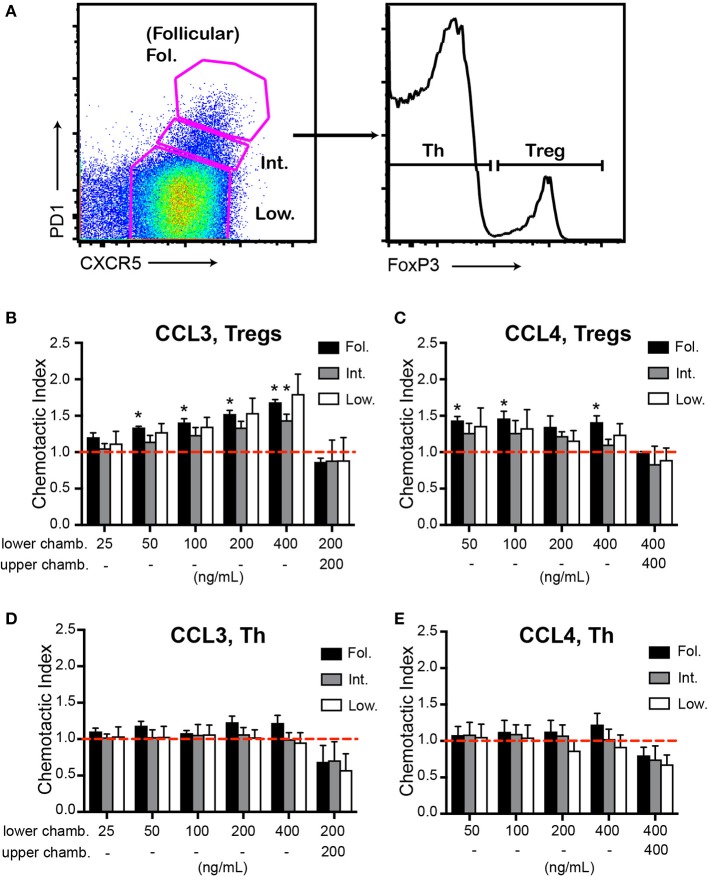
Chemotaxis of Tfr cells to CCL3 and CCL4 ex vivo. (A–E)
Ex vivo transwell assay of CD4+ T cells purified from dLNs of WT mice at 10 d.p.i. with 100 μg OVA in Ribi and analyzed by flow cytometry using the gating strategy as in (A). Transmigration of CXCR5highPD1high (Fol., black bars), CXCR5intPDint (Int., gray bars), or CXCR5lowPD1low (Low, white bars) CD4pos CD8neg B220neg cell populations that also express Foxp3 (B,C) or were FoxP3neg
(D,E) were measured against CCL3 (B,D) and CCL4 (C,E). The chemokines were added either to the lower chambers (chamb.) of transwells for analysis of chemotaxis or to both the upper and the lower chambers for analysis of chemokinesis. Chemotactic index was calculated as the ratio of cells that transmigrated toward the chemokine vs. no chemokine control (dashed red line). Chemotaxis and chemokinesis data are derived from 3 and 2 independent experiments correspondingly with 2 mice per experiment. Bars represent mean ± SEM, *P < 0.05, two-tailed, one-sample Student's t-test (compared to 1).